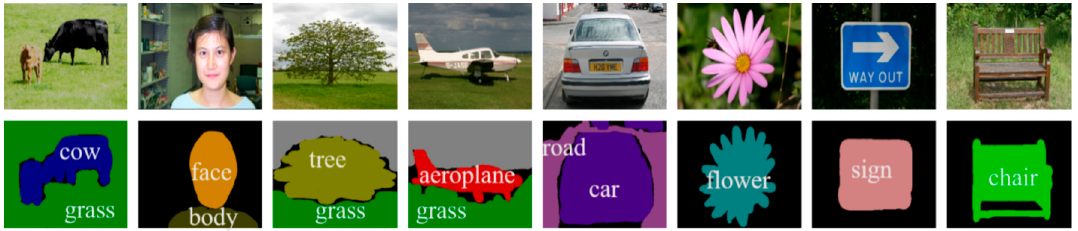
Figure 3. A set of images and their corresponding ground-truth annotations.